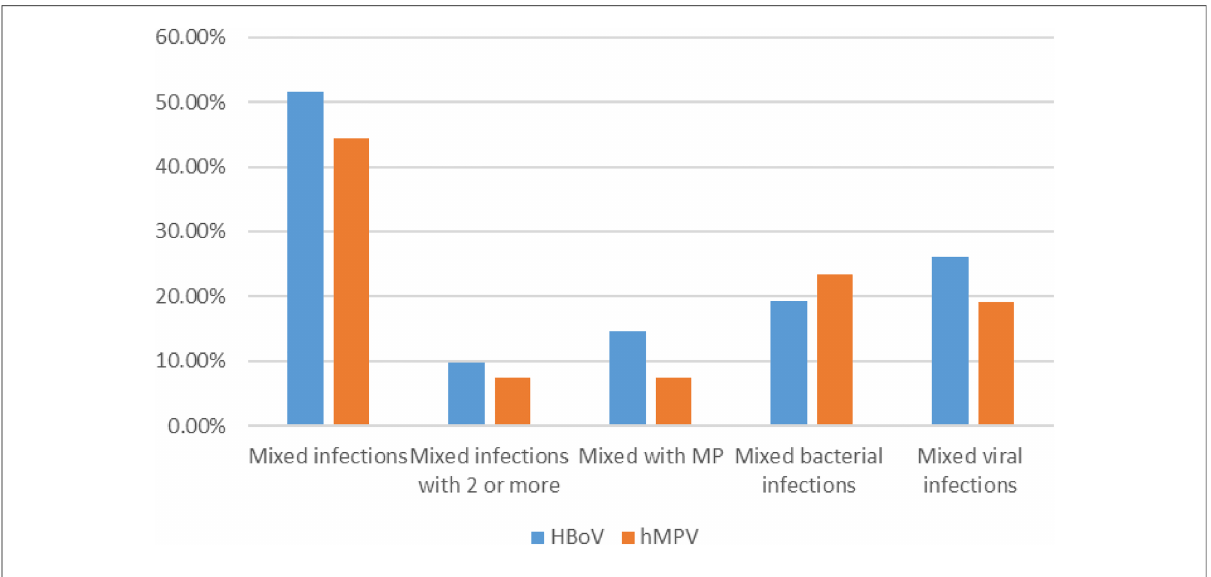
FIGURE 2 Detection rates of mixed infections in both groups are shown in Figure 2